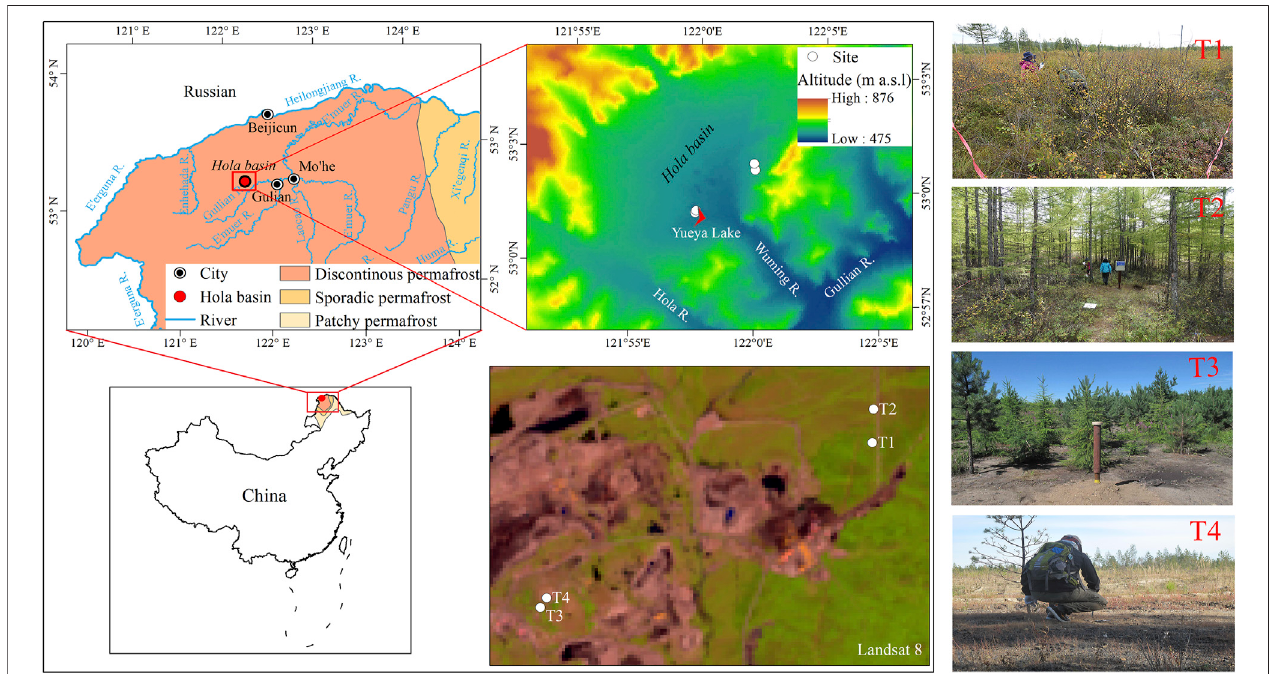
FIGURE 1 | Study region and sites in the Gulianhe Strip coalmine in the Hola Basin in the northern Da Xing ’ anling Mountains in Northeast China.